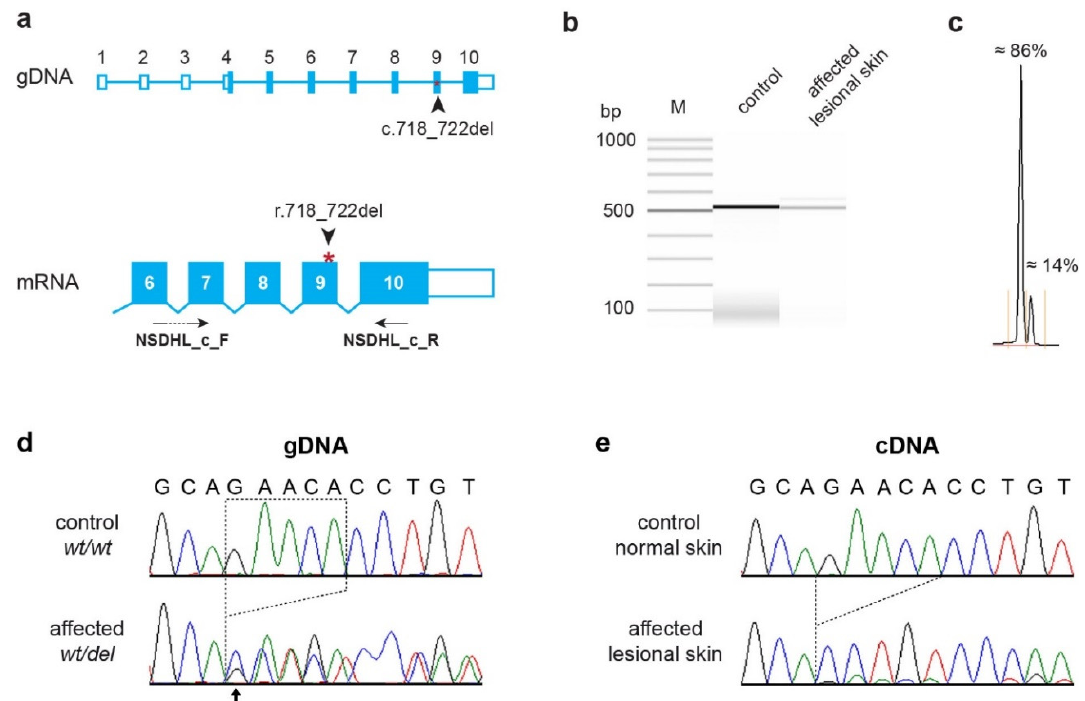
Figure 2. Details of the NSDHL :c.718_722delGAACA variant. ( a ) Genomic organization of the canine NSDHL gene with 10 annotated exons. The position of the variant on the genomic DNA and the mRNA level are indicated. The position of the primers used for the RT-PCR experiment are also indicated. ( b ) RT-PCR amplification products obtained from cDNA from skin of a healthy control and lesional skin from the affected dog. The samples were analyzed on a FragmentAnalyzer capillary gel electrophoresis instrument. The predominant band in the affected dog corresponds to a correctly spliced transcript lacking 5 nucleotides of coding sequence (r.718_722del). The minor band that